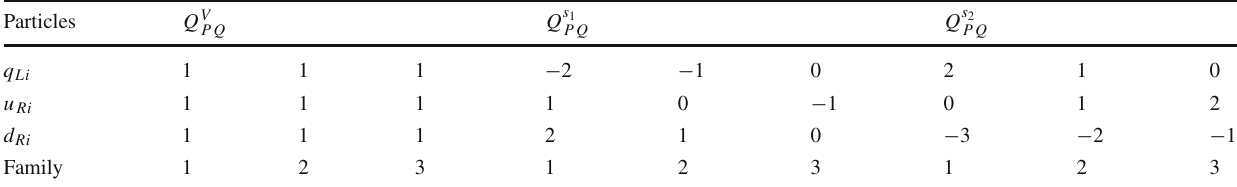
and down-type x d i